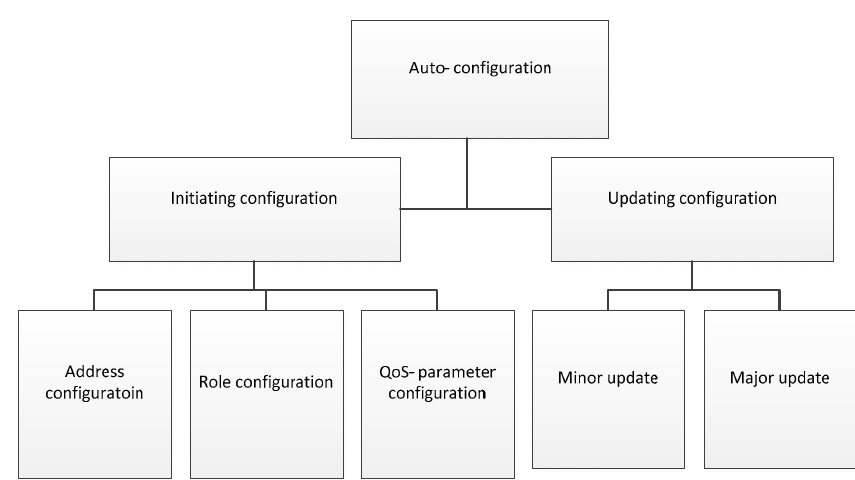
Figure 1. The taxonomy of the existing auto-configuration schemes in wireless sensor network (WSNs).